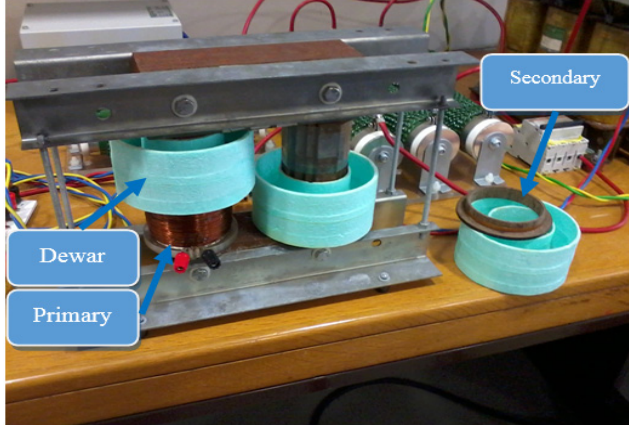
Fig. 2. SFCL prototype with primary and secondary. The primary is wrapped around an acrylic holder, while the secondary is wrapped around a Celeron holder and placed inside a